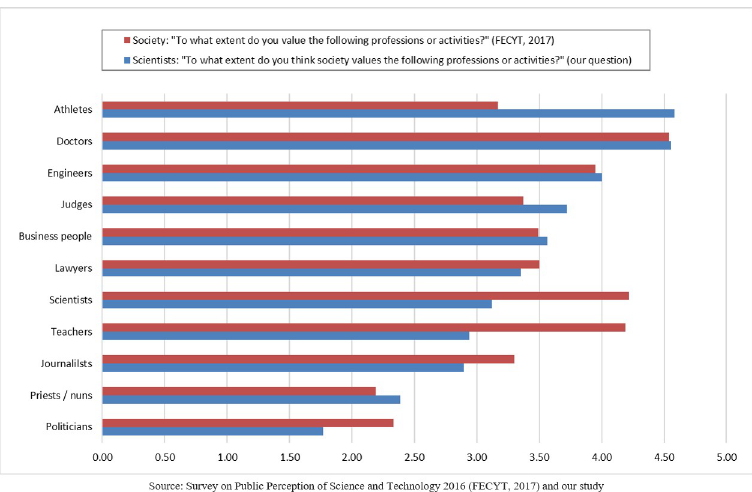
Fig 7. The perceived level of public recognition of professions by society in general (FECYT 2016 data) and by scientists (our data).